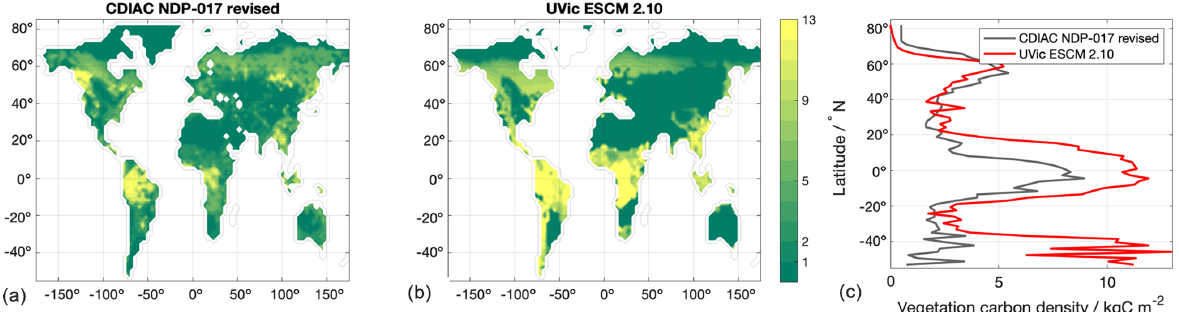
Figure 7. Vegetation carbon density for the 1960–2000 period (in kgCm − 2 ) from the revised CDIAC NDP-017 dataset (Olson et al., 2001) ( a ; grey line in c ) and the UVic ESCM 2.10 ( b ; red line in c ). Zonally averaged values as a function of latitude (c) .